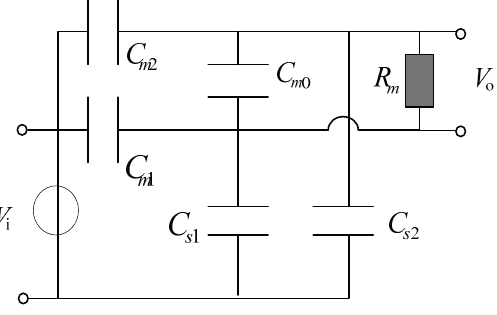
Figure 1. Equivalent circuit of the differential D-dot